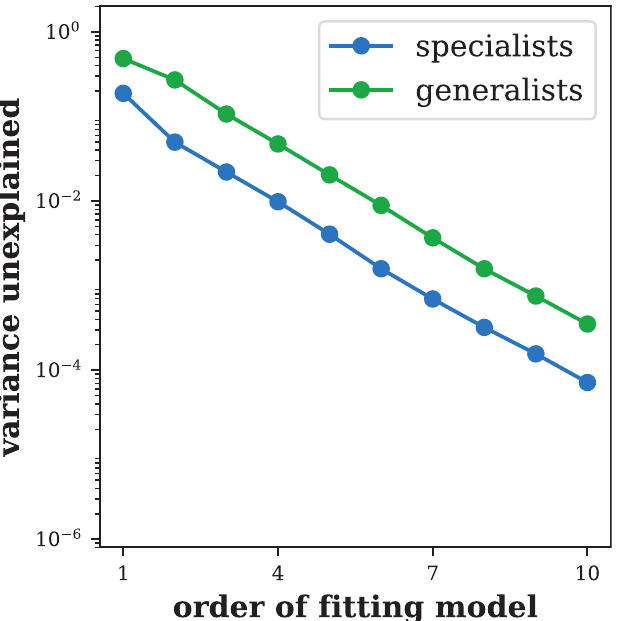
Fig 6. Contribution of higher-order interactions. Including higher order terms in the fitting model reduced the variance in the data not explained by the fit. First order fitting models are linear, second—quadratic, etc. The decrease in unexplained variance was approximately exponential. We used S = 16, M consumed = 2 for specialists and M consumed = 14 for generalists; the community function was Shannon diversity. All other simulation parameters are the same as in Fig